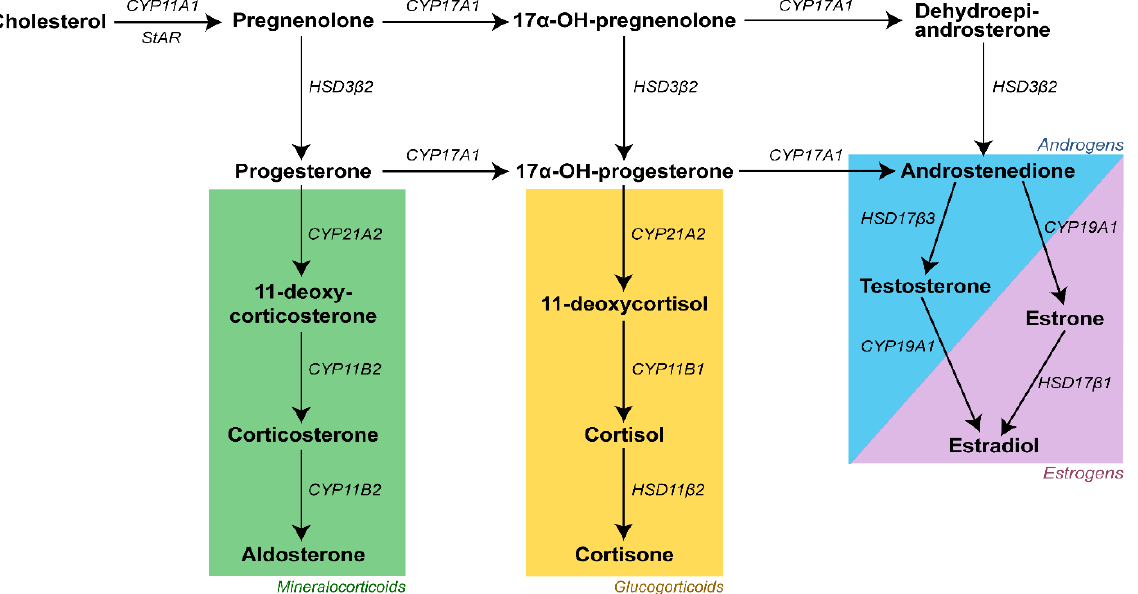
Figure 1. Overview of the steroid hormone synthesis in H295R cells. Hormones are written in bold, and the enzymes catalyzing the different steps are written in italics. Adapted from Jeanneret et al., 2016 [21].